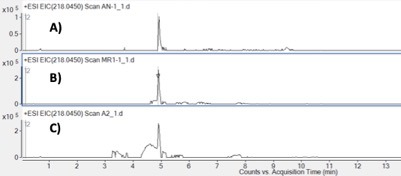
Production of ACNQ when grown with (A) NH4SO4, (B) NH4SO4 and amino acid mixture and (C) amino acid mixture as the sole nitrogen source.ACNQ production was observed under each growth condition. [Amino acid mixture (10x mixture): L-arginine: 1.26 g/L, L-cystine: 0.24 g/L, L-histidine HCl: 0.42 g/L, L-isoleucine: 0.52 g/L, L-leucine: 0.52 g/L, L-lysine HCl: 0.73 g/L, L-methionine: 0.15 g/L, L-phenylalanine: 0.33 g/L, L-threonine: 0.48 g/L, L-tryptophan: 0.1 g/L, L-tyrosine: 0.36 g/L, L-valine: 0.467 g/L].